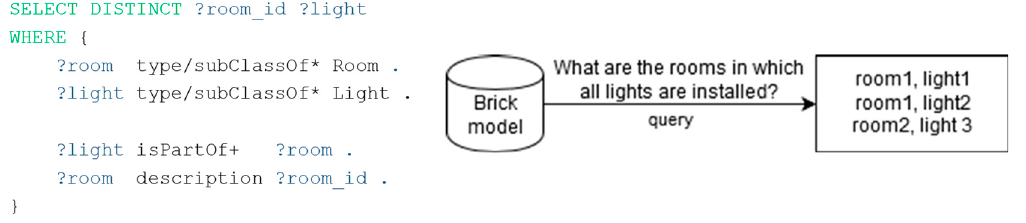
Figure 5. Query for collecting spatial information about lights in SPARQL on the left and an illustration of the query question and example results on the right.